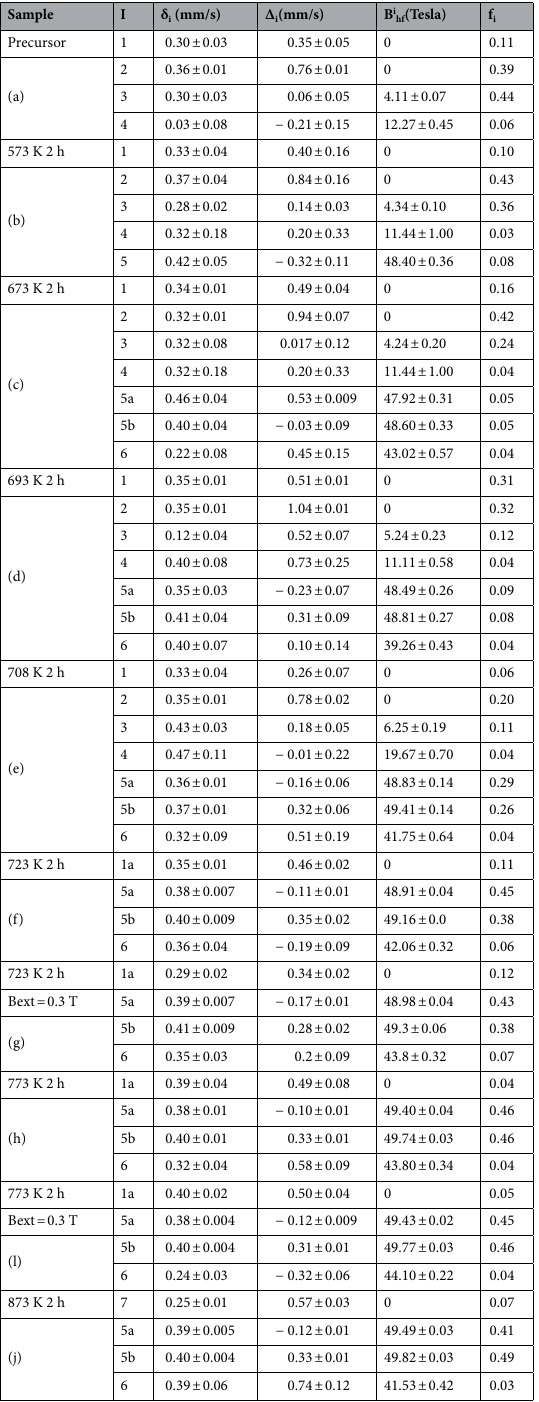
Table 1. Results of hyperfine parameters as obtained in the precursor calcinated at different temperatures. f 1 and f 2 are due to relative fractions of iron atoms associated with nanoparticles of Bi 25 FeO 40 and superparamagnetic particles (SPM) of BiFeO 3 and α-Fe 2 O 3 . f 3 is the fraction of iron atoms associated with nanoparticles of BiFeO 3 with size larger than the SPM limit and much lesser than that of bulk BiFeO 3 as deduced based on the hyperfine parameters. f 4 is the fraction of iron atoms associated with BiFeO 3 particles of size larger than that of f 3 . f 5a ,f 5b are the fractions of iron atoms associated with that of bulk BiFeO 3 particles, while f 6 is interpreted to be due to iron atoms associated with shell with core as BiFeO 3 . In the case of precursor annealed at 873 K and beyond the fraction f 7 is attributed to Fe atoms associated with the shell of Bi 25 FeO 40 formed at the surface of large sized BiFeO 3